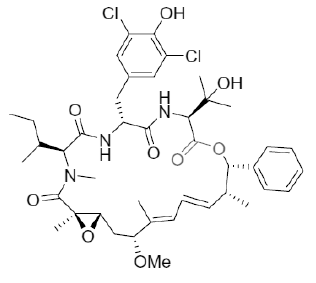
Figure 7. Structure of nannocystin